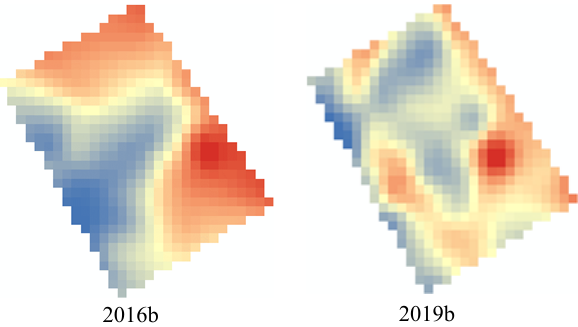
Figure 6. Inversion Results of Area 2 Surface Temperature According to the inversion results of surface temperature in area 2, it is found that the temperature has not changed much after the building area is built, and the temperature increase is not large compared with that before the building area is built. This result is the same as that obtained in Area 1. Compared with the houses and villages built in 19 years, it is found that the temperature of villages is higher than that of houses. This result is due to less vegetation among villages and a lot of greening around the housing area.